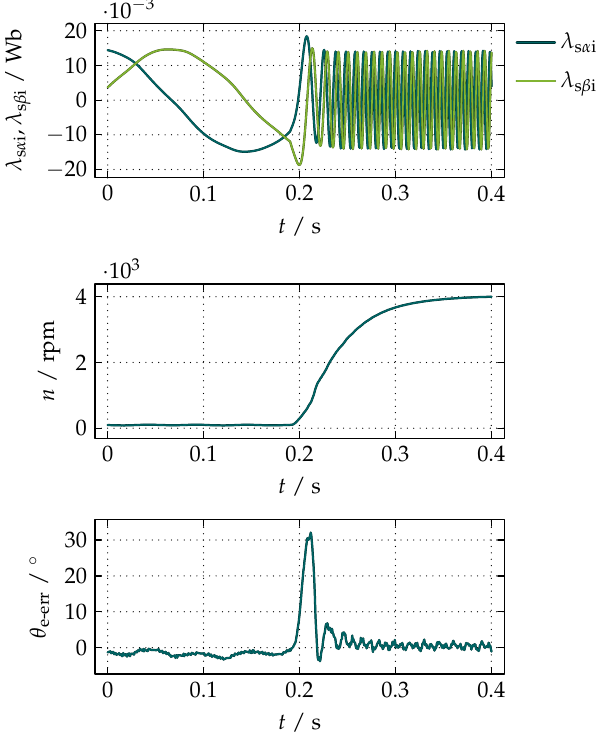
Figure 18. A step from 100 rpm to 4000 rpm within 0.2 s without any